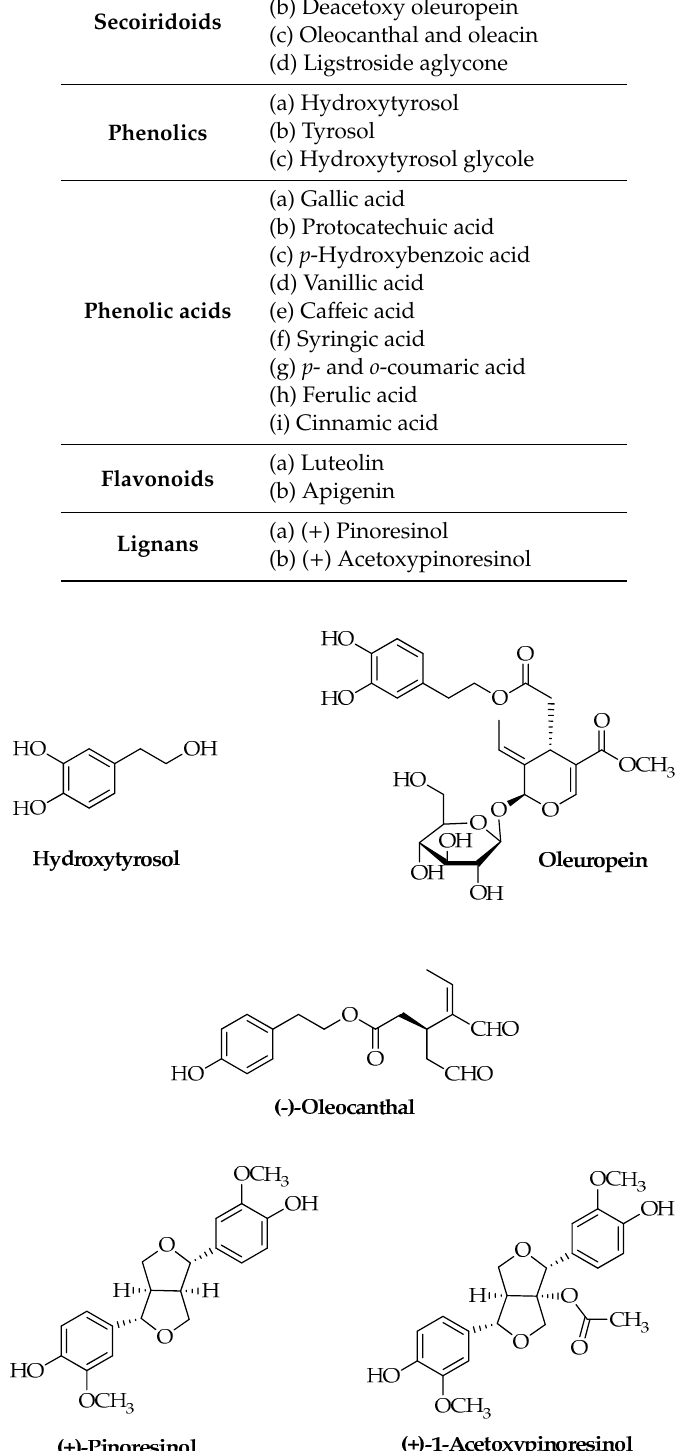
Figure 1. Chemical structure of the main phenolic compounds found in Olea europaea L.